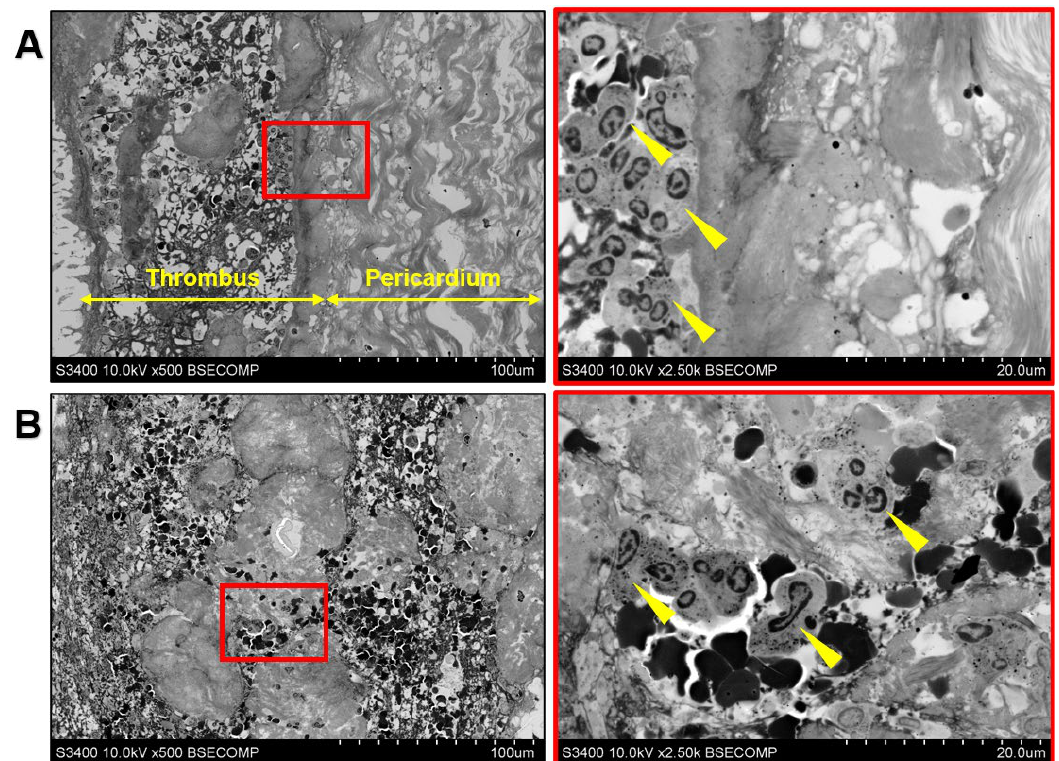
Figure 2. Ultrastructural analysis of thrombotic masses and prosthetic tissues. ( A ) Neutrophil-free BHV (pericardium) as compared to the neutrophil-rich clot (thrombus). Right image represents a close-up of the left image (demarcated by a red contour). Yellow arrows at the left image demarcate thrombus and bioprosthetic bovine pericardium. Yellow arrows at the right image indicate neutrophils. Magnification ×500, scale bar = 100 µm (left image) and magnification ×2500, scale bar = 20 µm (right image); ( B ) Neutrophil-rich left atrial clot. Right image represents a close-up of the left image (demarcated by a red contour). Yellow arrows at the right image indicate neutrophils. Magnification ×500, scale bar = 100 µm (left image) and magnification ×2500, scale bar = 20 µm (right image). Backscattered scanning electron microscopy (EM-BSEM method) [15], accelerating voltage 10 kV.